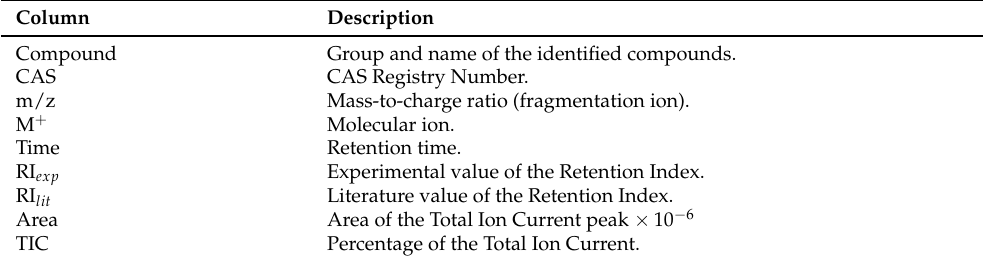
Table A4. Description of the columns in tables presenting the Gas Chromatography–Mass Spectrom- etry